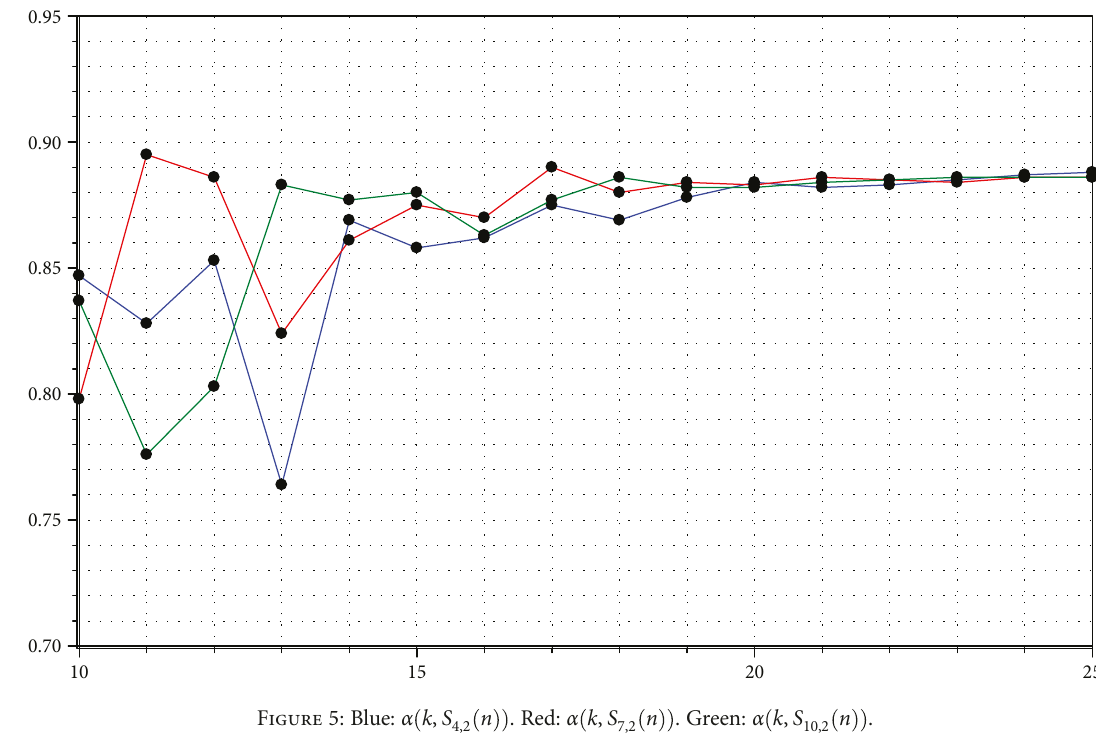
n . Green: α k , S 7,2